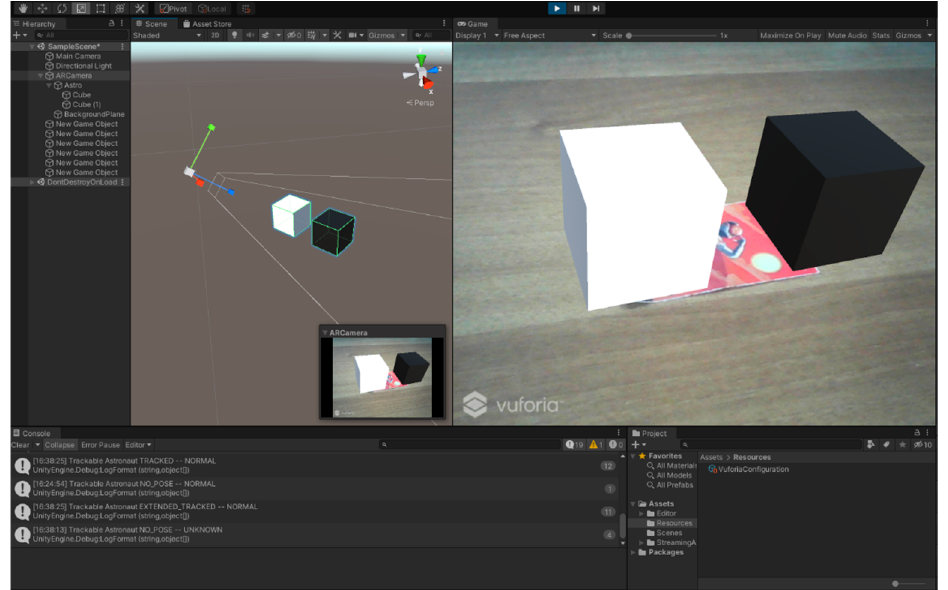
Figure 9. A solid black cube framed with a webcam in the Unity Editor. Experiment carried out at University of Bologna by the authors. University of Bologna by the